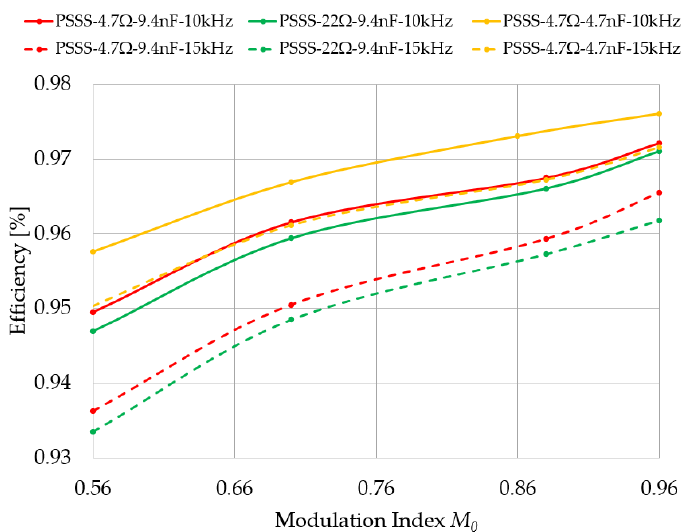
Figure 14. Efficiency of the three-phase S2L inverter as a function of modulation depth M 0 with l C = 15 m V BUS = 400 V, I x = 30 A.